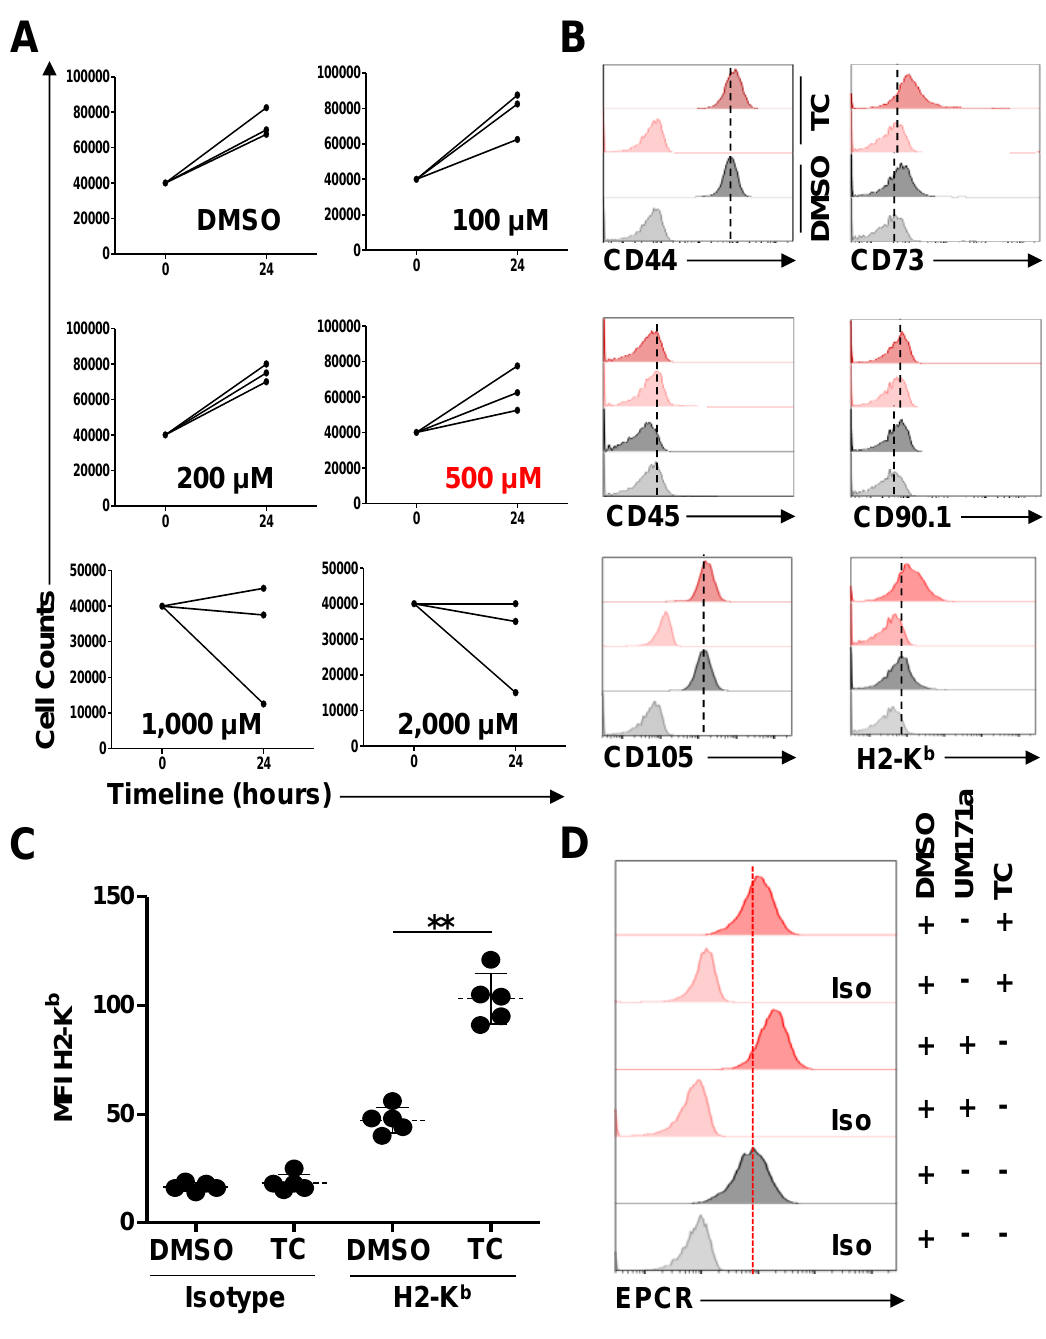
Figure 1. TC treatment enhances MHCI and EPCR expression on the surface of MSCs. ( A ) An MTD experiment conducted on MSCs using ascending doses of TC. Cell counting was conducted 24 h following treatment. For this experiment, n = 3/group. ( B ) Representative phenotypic analysis of MSCs treated with 500 µ M of TC. DMSO-treated groups are shown in gray, whereas TC-related groups are displayed in red. ( C ) MFI of H2-K b expression following DMSO or TC treatments. For this experiment, n = 5/group, with ** p < 0.01. ( D ) Representative flow-cytometry analysis of EPCR expression in response to TC and UM171a treatments.